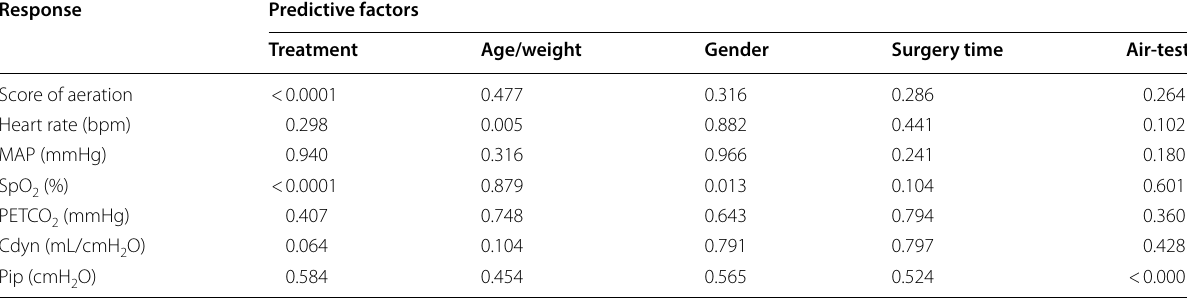
MAP mean arterial blood pressure, SpO 2 pulse oximetry hemoglobin saturation, PETCO 2 end-tidal partial pressure of carbon dioxide, Cdyn dynamic respiratory compliance, Pip peak inspiratory